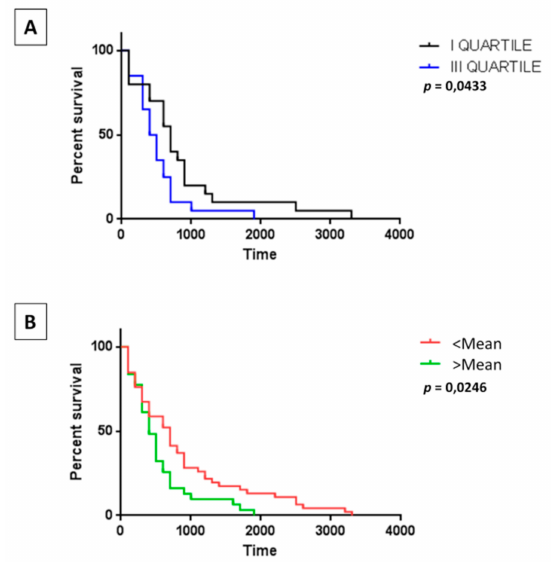
Figure 1. The tumor mutational burden (TMB) on survival. Survival of Hepatocellular carcinoma (HCC) patients in the I and III quartile of TMB ( A ), as well as in the patients with a TMB below and above the mean value ( B